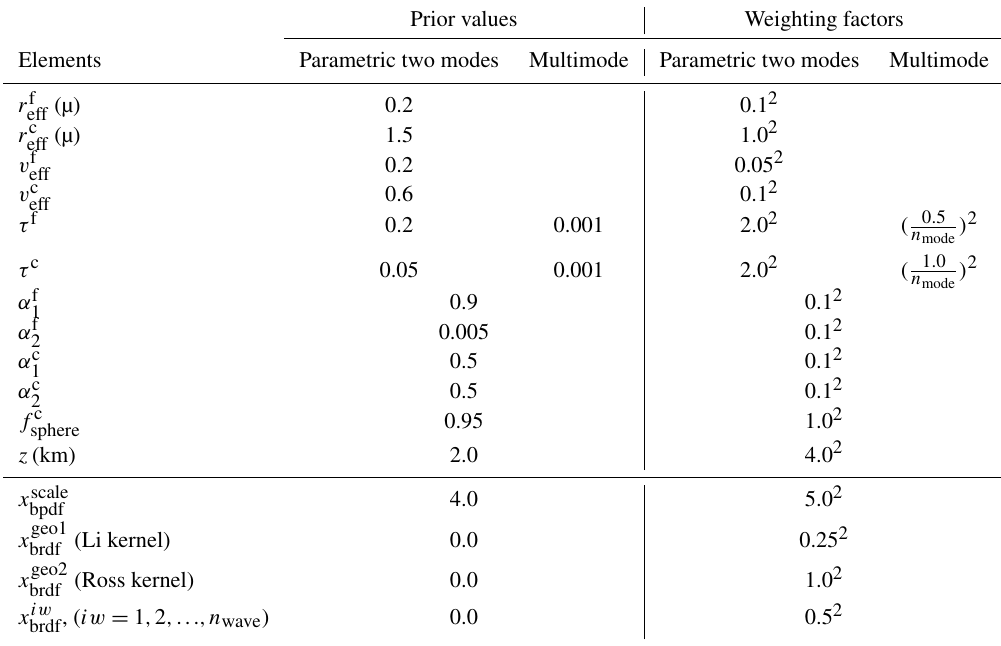
Table 5. Prior values and weighting factors for the state vector in the parametric two-mode retrieval and the multimode retrieval. The prior value and weighting factor of aerosol loading N for each mode are further calculated based on Mie theory using the prior information of τ f and τ c from the